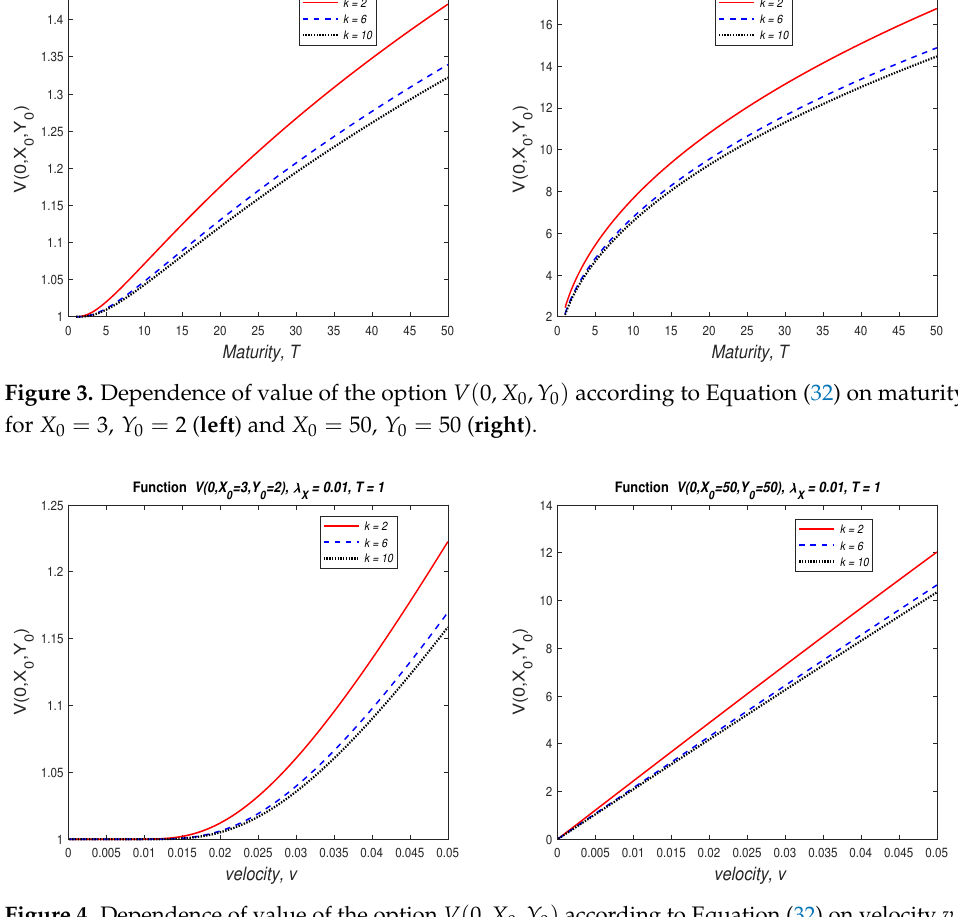
Figure 4. Dependence of value of the option V ( 0, X 0 , Y 0 ) according to Equation (32) on velocity v for X 0 = 3, Y 0 = 2 ( left ) and X 0 = 50, Y 0 = 50 ( right